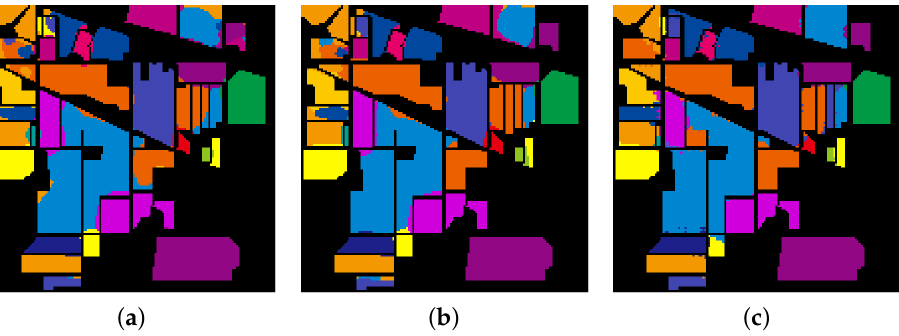
Figure 6. The classification maps of IP. ( a – c ) Classification results of AAE, VAE, and our proposed model,